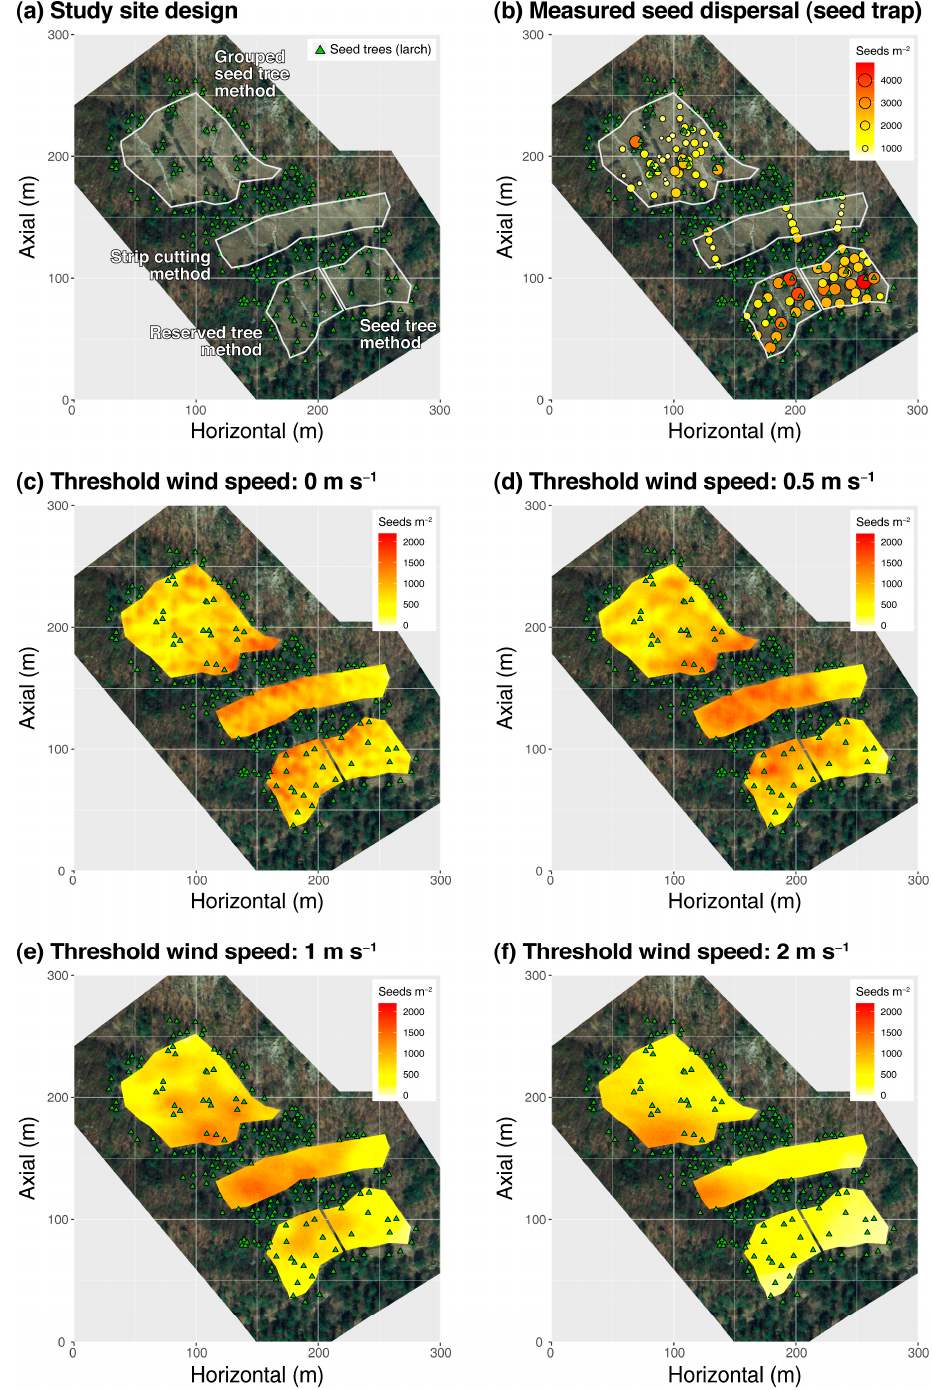
Figure 2. Distributions of natural regeneration patches and seed trees ( a ), measured seed dispersal using seed traps ( b ) and predicted seed dispersal using wind flow dataset filtered by different wind speed thresholds ( c – f ). Third, various inherent complexities contribute to errors in seed dispersal predictions.